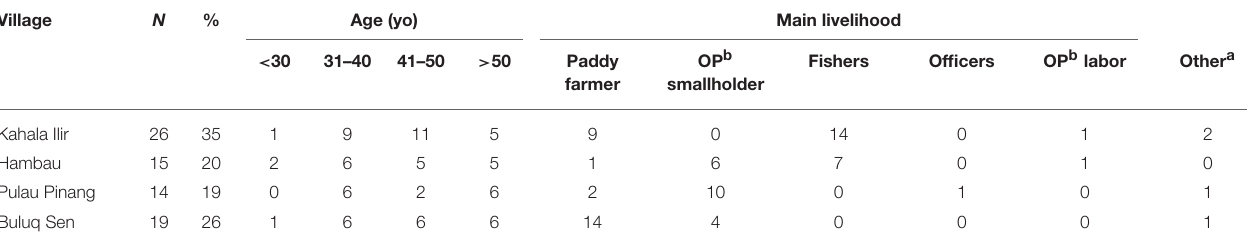
TABLE 2 | Respondents of interviews in four